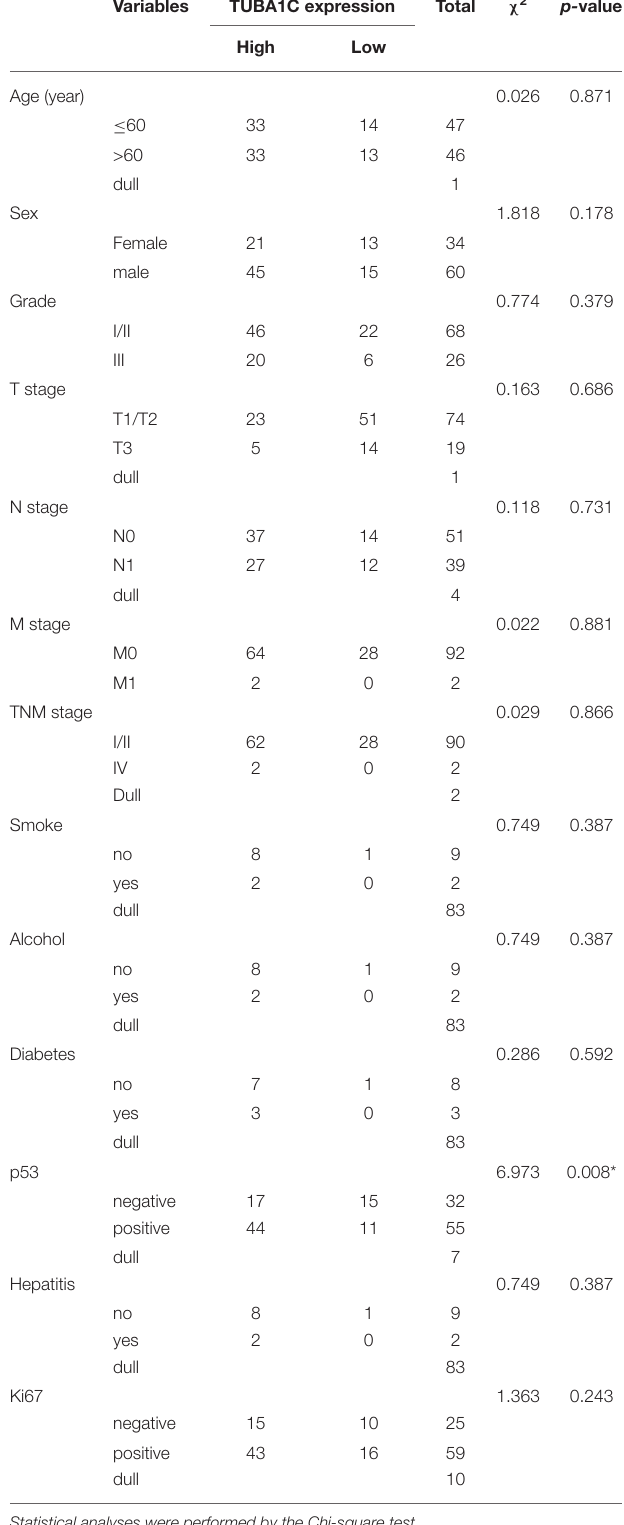
TABLE 2 | Correlation between TUBA1C expression and clinicopathological characteristics.